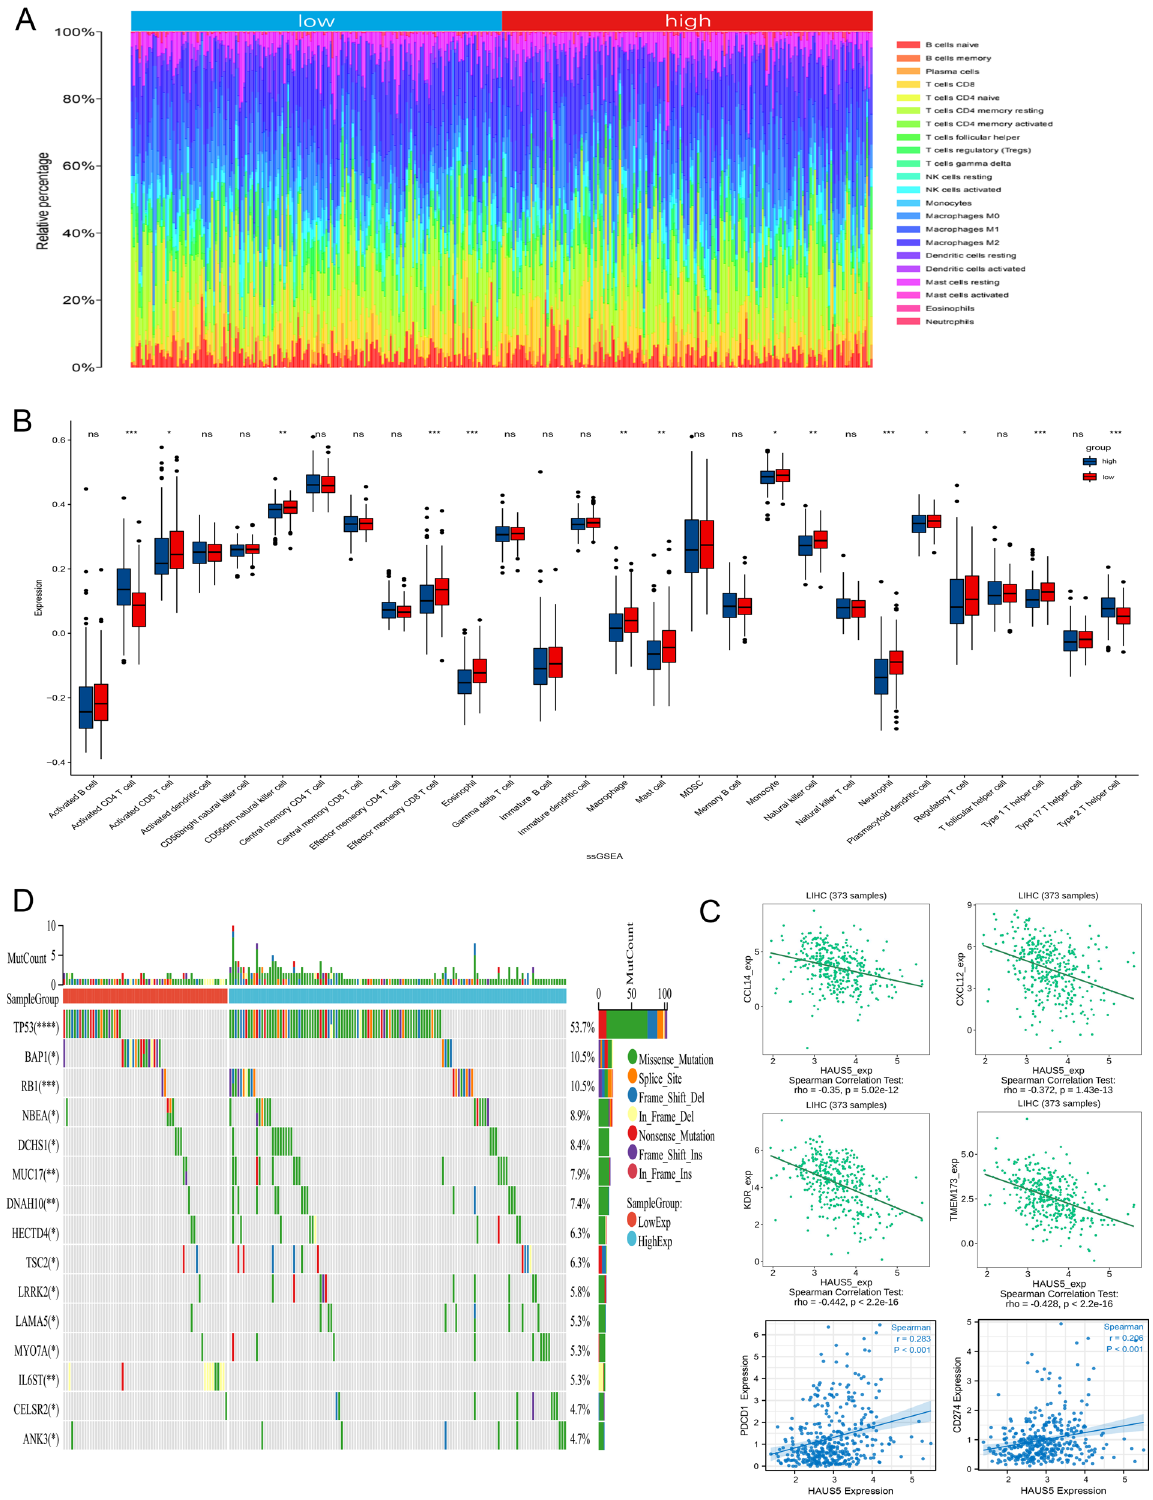
Figure 8. HAUS5 expression was correlated with immune infiltration and mutations in the tumor microenvironment. ( A ) The infiltration of 22 immune cell types in TCGA-LIHC patients. ( B ) The boxplot shows the correlation between HAUS5 expression and 28 immune cell subsets. ( C ) Correlation between HAUS5 expression and immunomodulatory targets. ( D ) The top 15 genes mutation information in liver cancer samples showed in the waterfall plot. *P < 0.05, **P < 0.01, ***P < 0.001. ns, no statistical